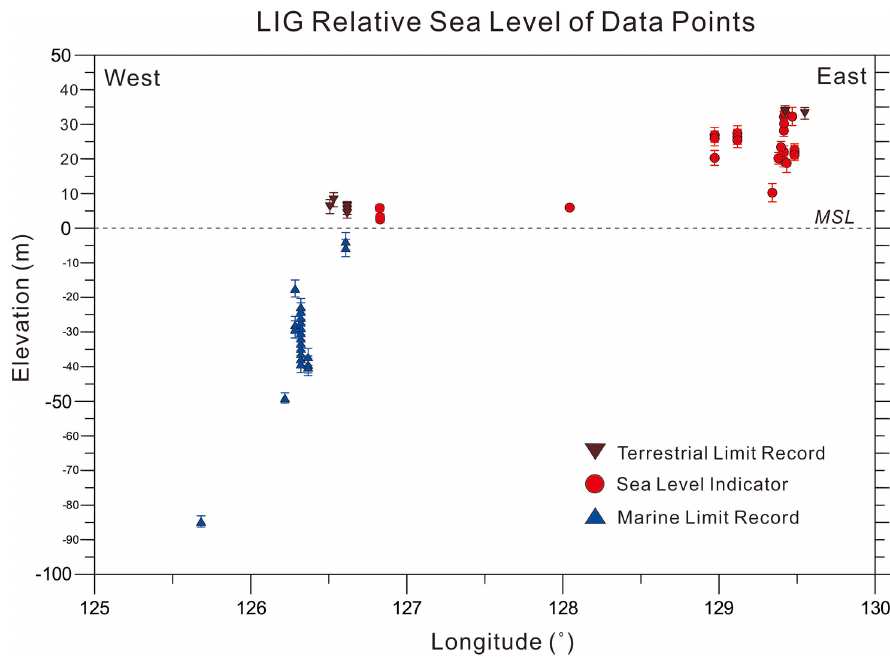
Figure 15. LIG relative sea levels with respect to longitude across the Korean Peninsula. See Table 3 for more